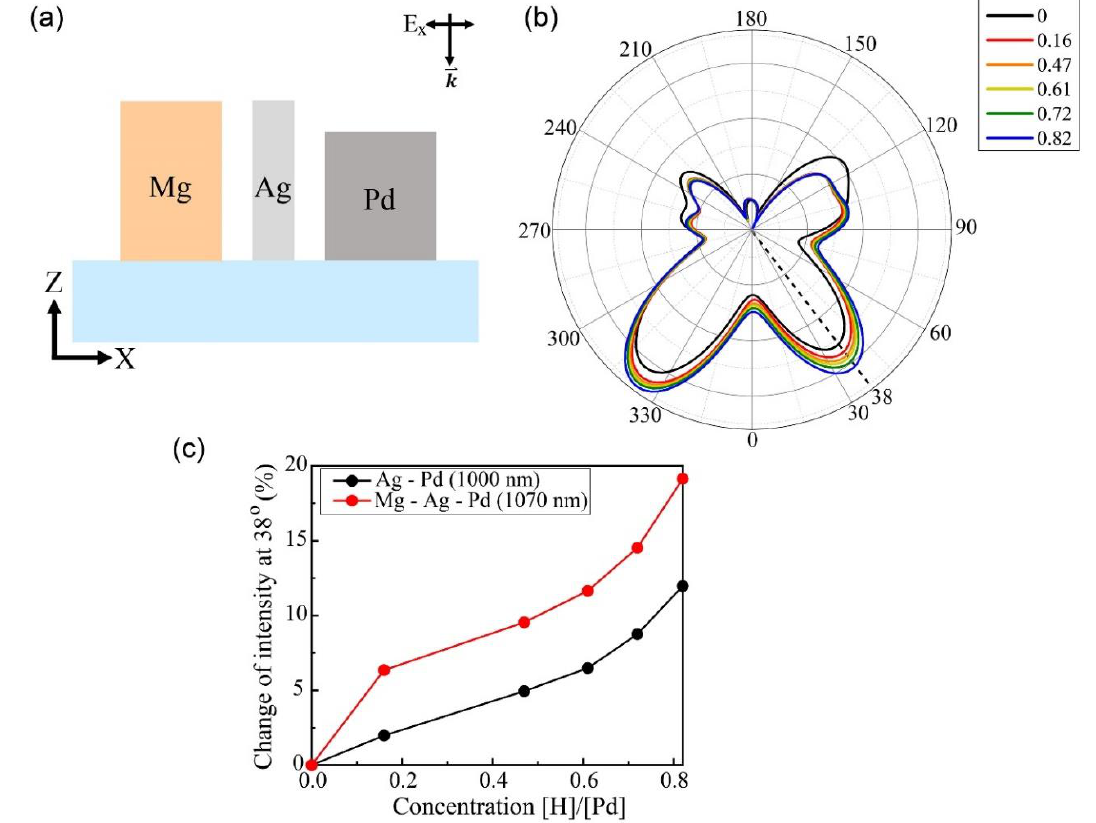
Figure 6. ( a ) Schematic of hydrogen sensor composed of Mg (H = 230 nm; L = 150 nm), Ag (H = 230 nm; L = 50 nm), and Pd nano-blocks (H = 200 nm; L = 150 nm) with two 50 nm air gaps. ( b ) Far-field scattering intensity with respect to hydrogen concentration (H/Pd) at 1070 nm incident wavelength. ( c ) Changes in far-field scattering intensities of two sensors at 38° with respect to hydrogen concentration (0 – 0.82); black curve indicates results of sensor with only Ag and Pd nano-blocks at 1000 nm wavelength; red curve indicates results of sensor with Mg, Ag, and Pd nano-blocks at 1070 nm wavelength.